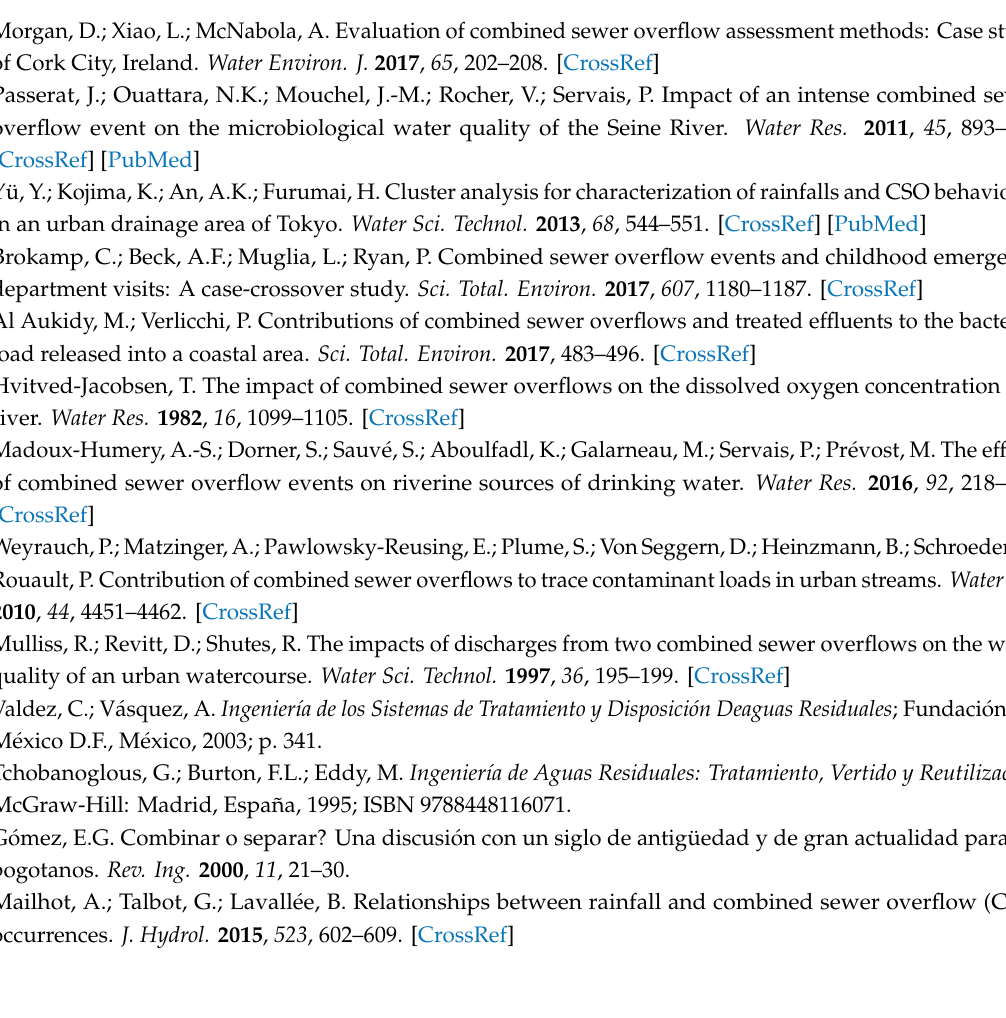
PLS model of the Coliseo CSO in the same graph.